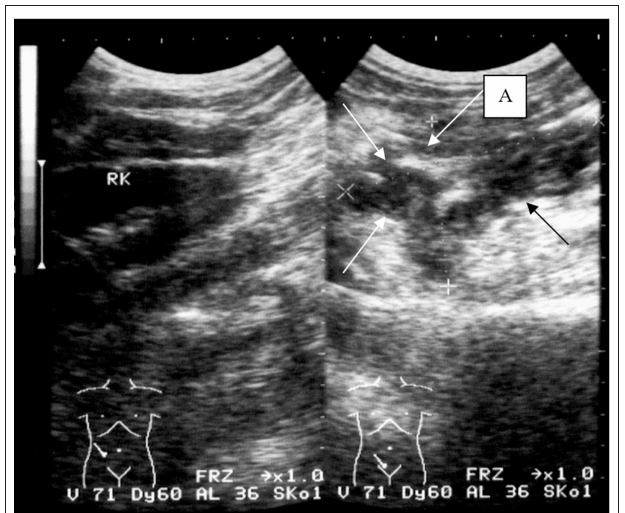
FIGURE 2 | X-ray image of the abdominal abscess in the right iliac region (arrows) and the ileocecal angle of the intestine